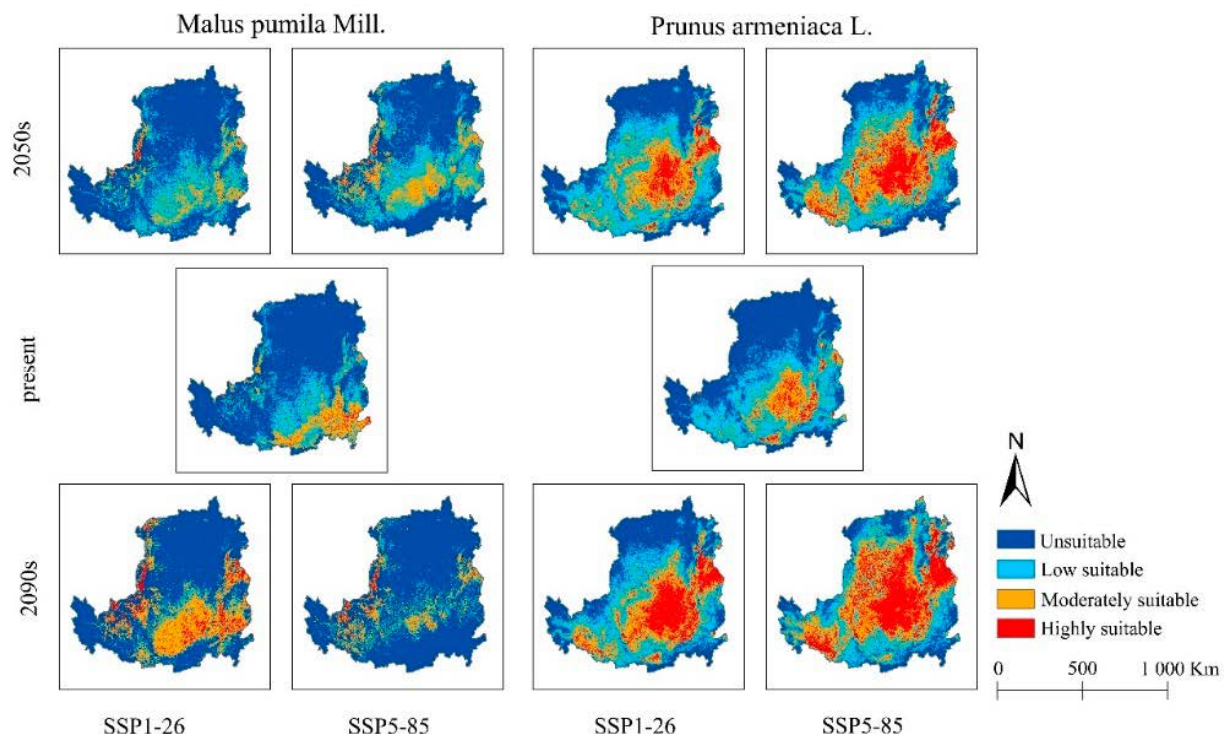
Figure 3. The habitat range of Malus pumila Mill and Prunus armeniaca L. in the Loess Plateau under different climate scenarios.